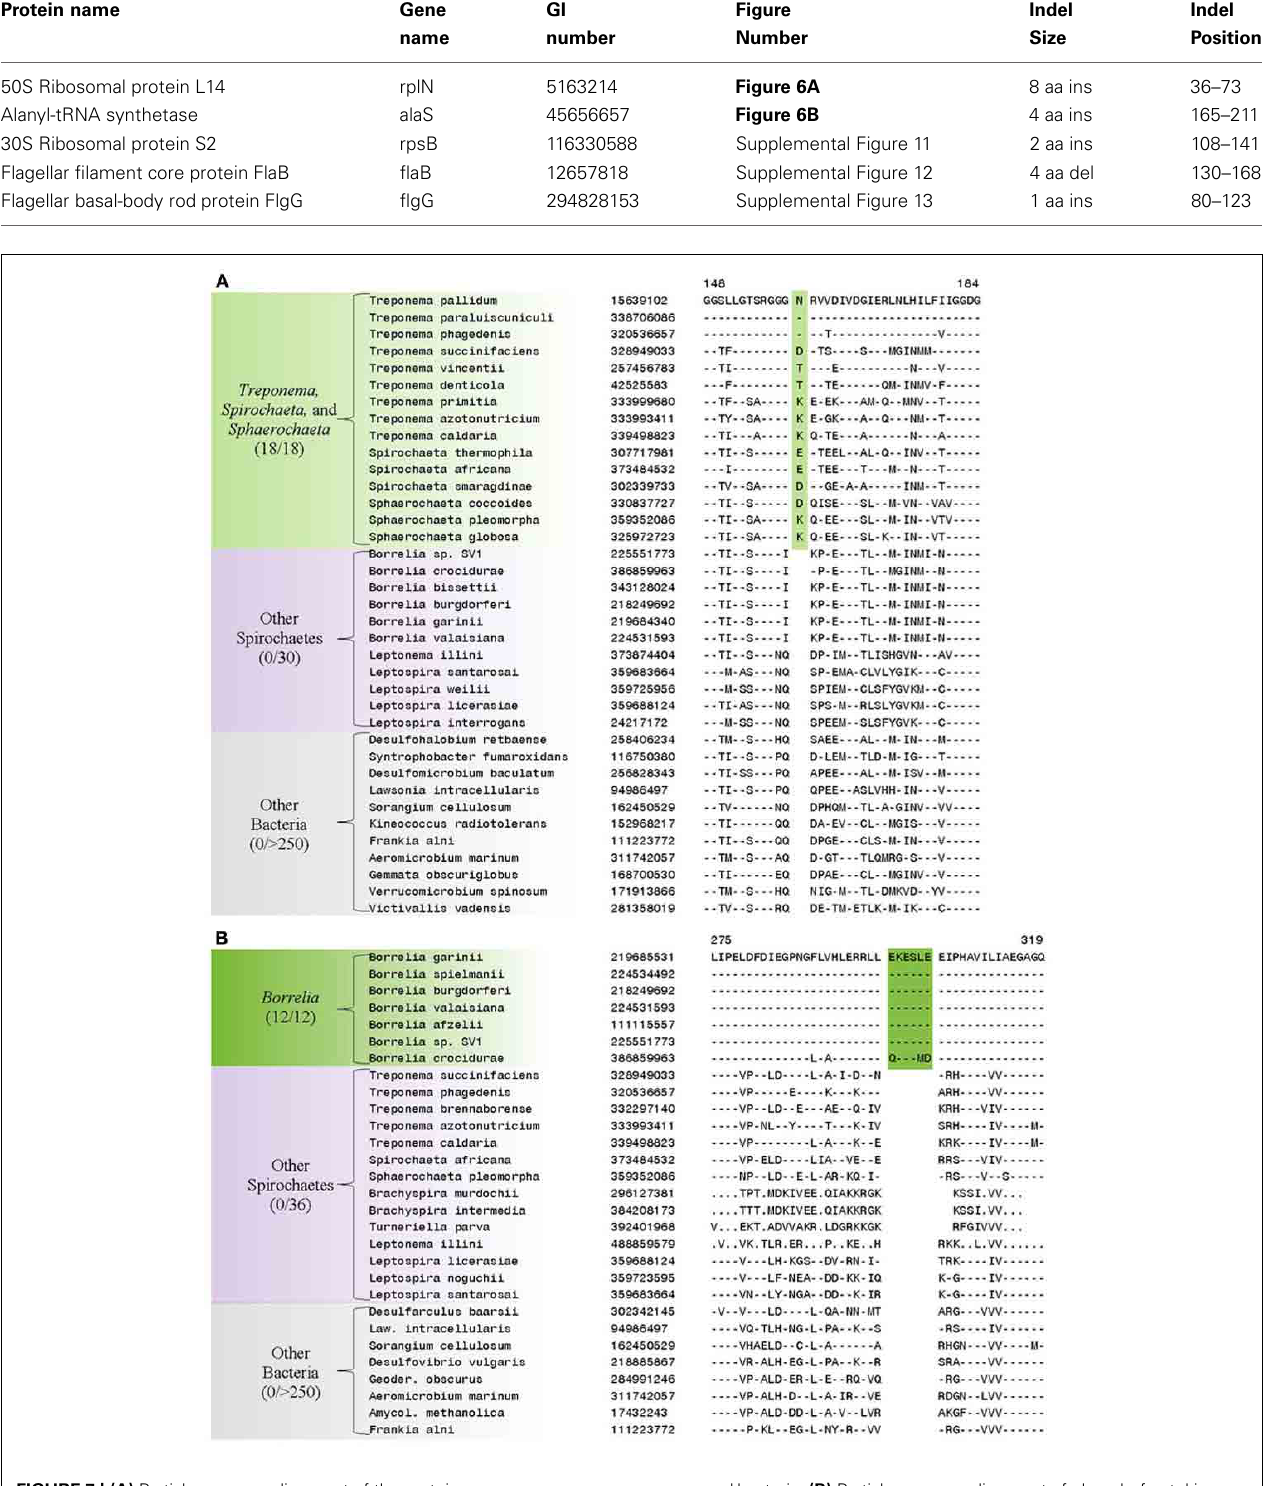
Table 4 | Conserved signature Indels that are specific for members of the family Leptospiraceae .